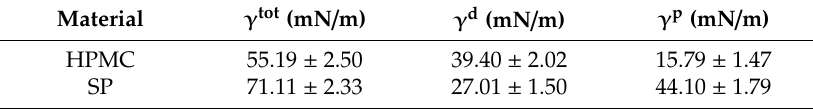
Table 2. The surface free energy results of starting